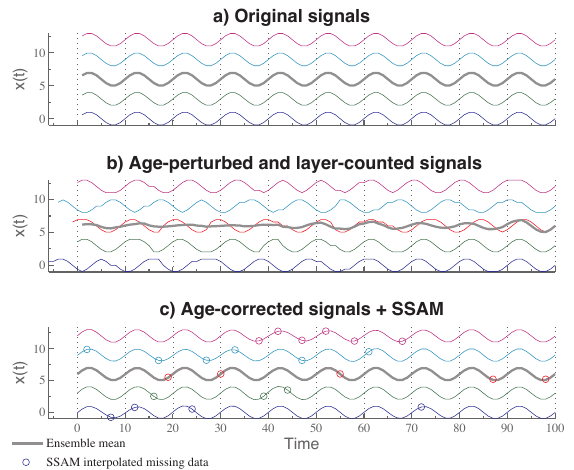
Fig. 2. Illustration of the phase distortion of coherent signals due to miscounted annual bands with θ 1 = θ 2 = 0 . 05 and a collection date t 1 = 100. (a) Five hypothetical and identical harmonic signals shifted vertically for clarity; (b) the same signals after introduc- ing age perturbations and making the (erroneous) assumption that 1 layer amounts to 1year (note the loss of coherency reflected in the ensemble mean in gray, which is performed as part of composites in most climate reconstructions); (c) the same age-perturbed sig- nals, after correcting for miscounted bands and interpolating miss- ing data with